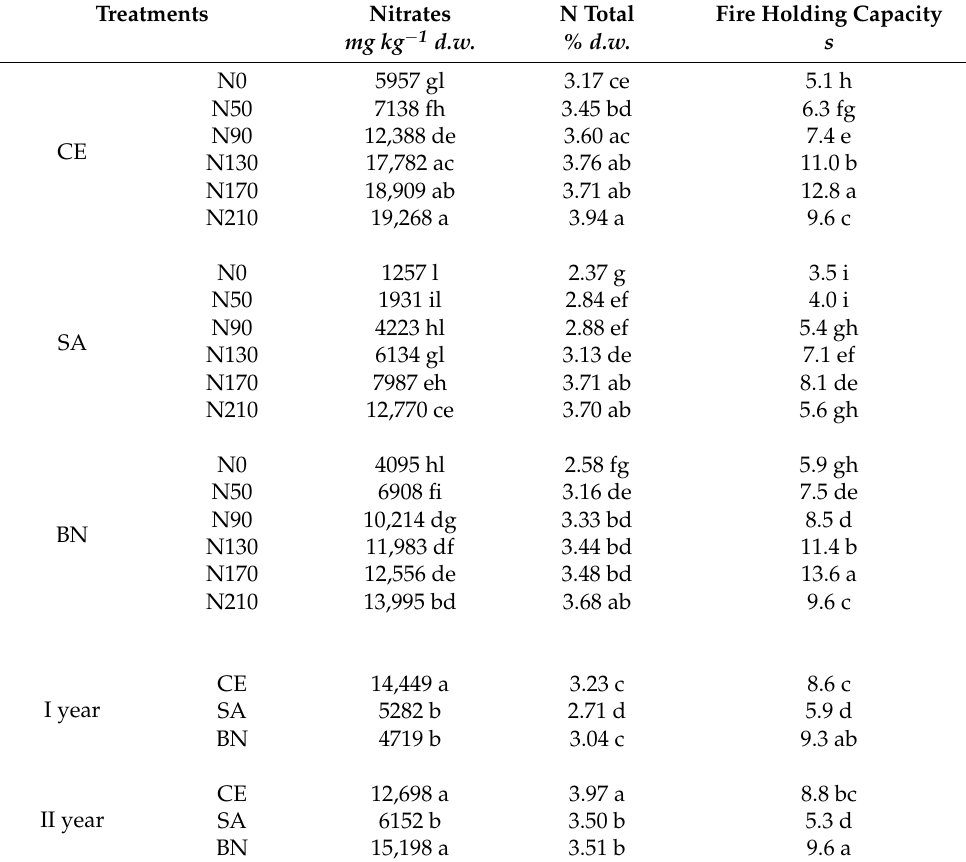
Table 3. The effect of Locations x N fertilization rates and Years x Locations on nitrates, total N and fire holding capacity of cured leaves; d.w., dry weight; s, seconds. Treatments Nitrates N Total Fire Holding